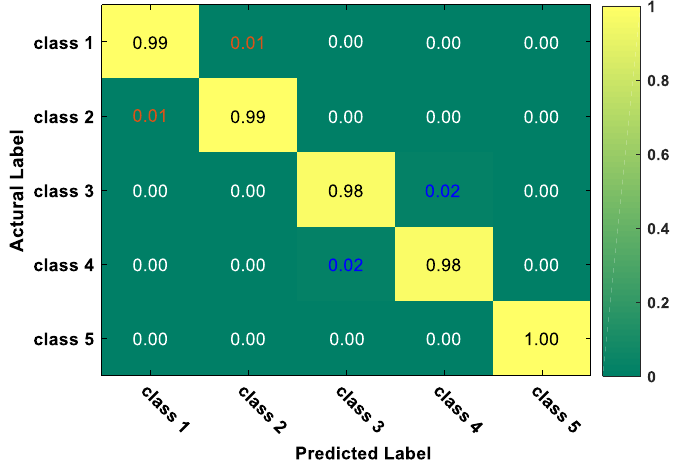
Figure 10. The multi-class confusion matrix of the proposed method.